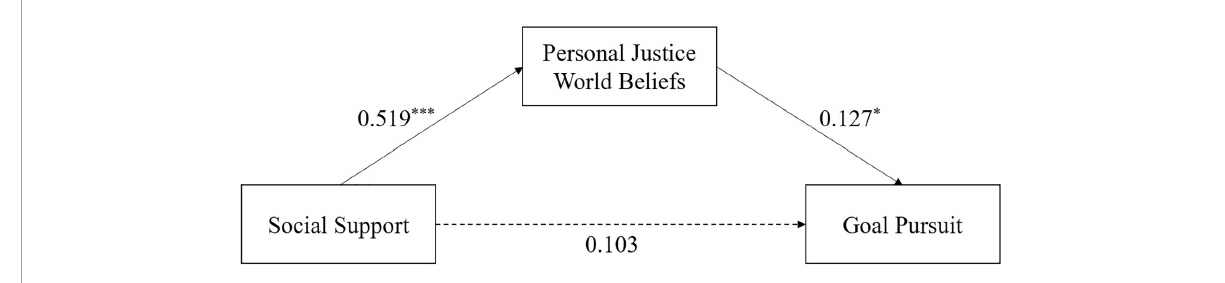
FIGURE4 Mediating effects of personal just-world beliefs. ∗ p < 0.05, ∗∗ p < 0.01, and ∗∗∗ p < 0.001.